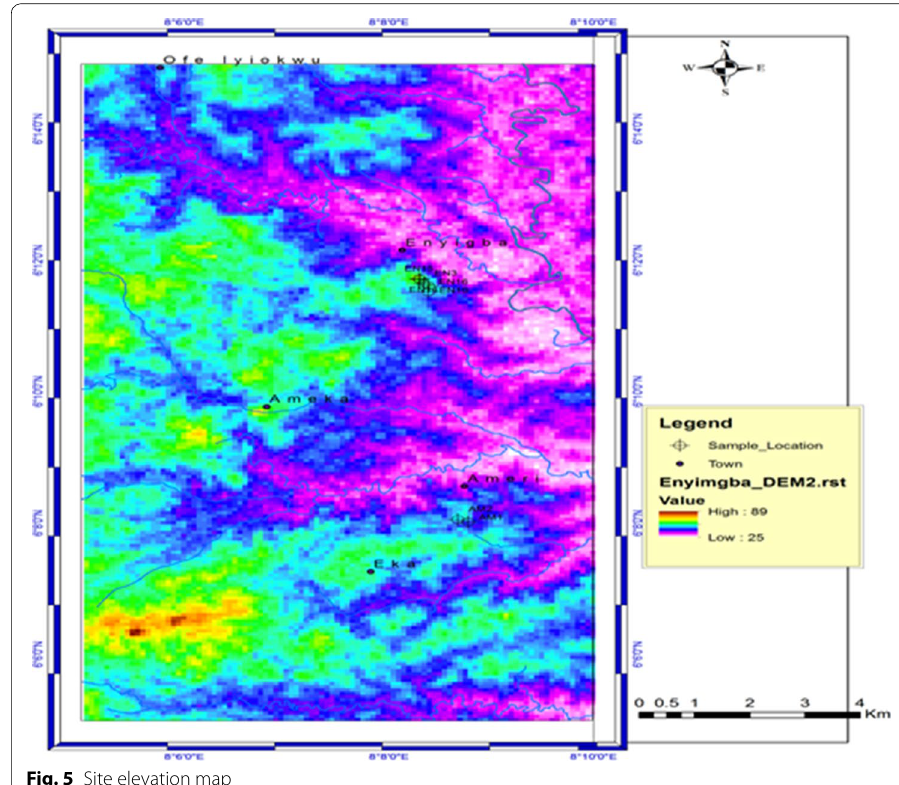
Fig. 5 Site elevation map